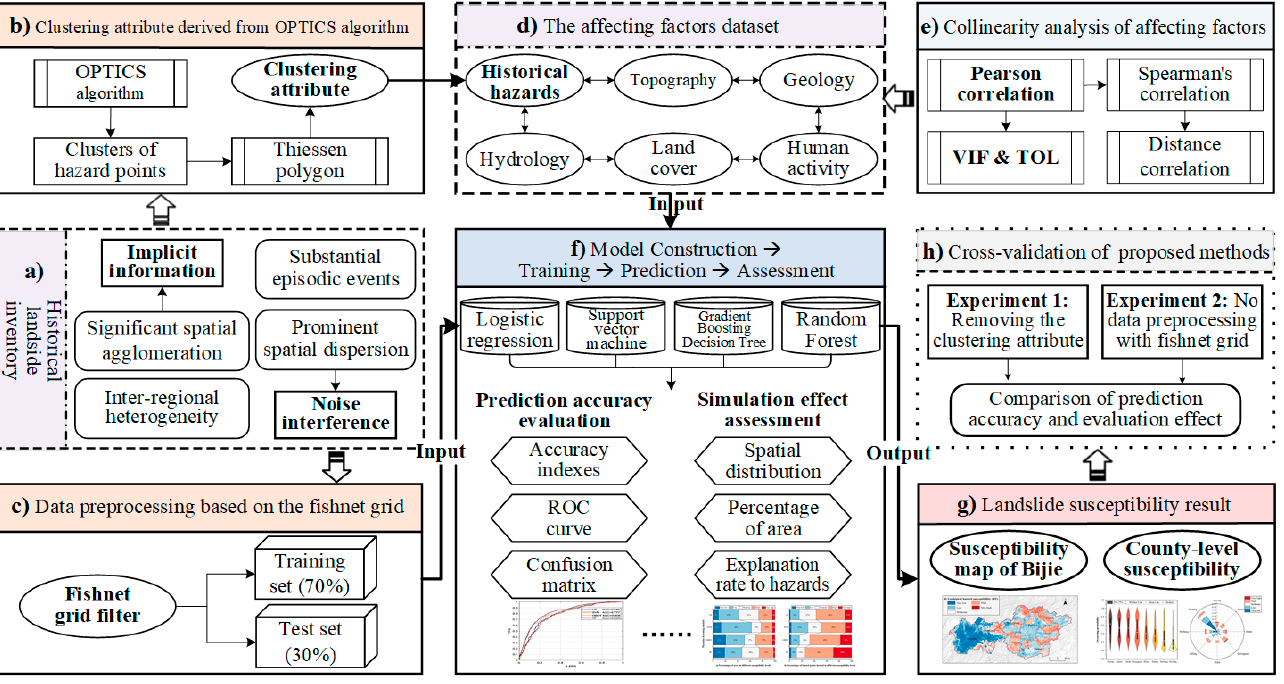
Figure 2. Framework of proposed method.